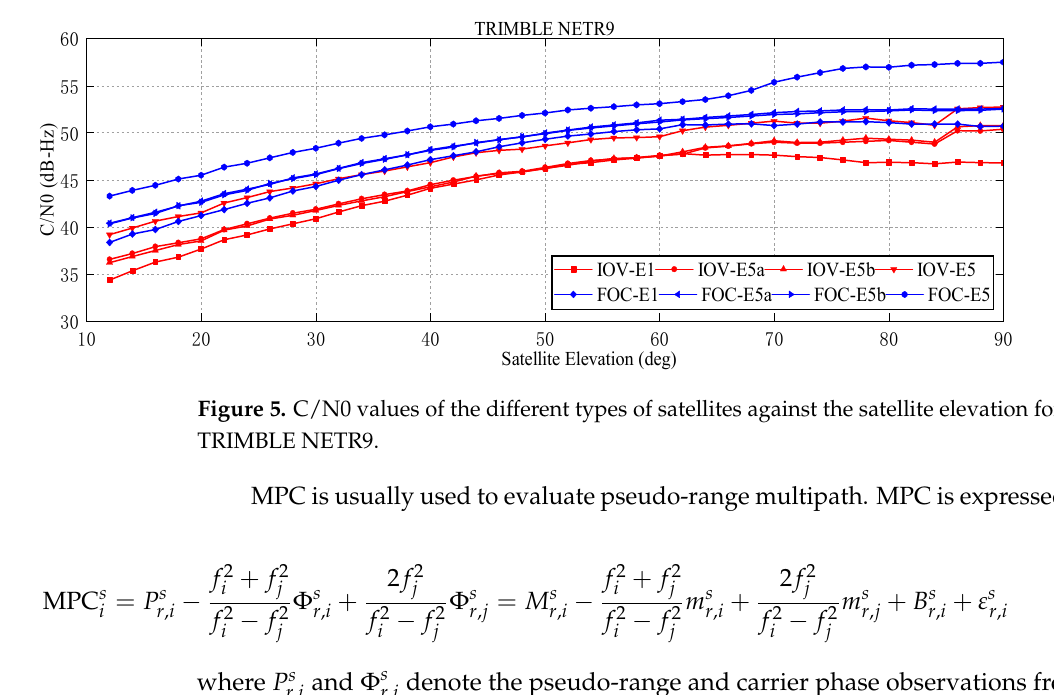
Figure 4. C/N0 values of the different types of satellites against the satellite elevation for the receiver SEPT POLARX5.